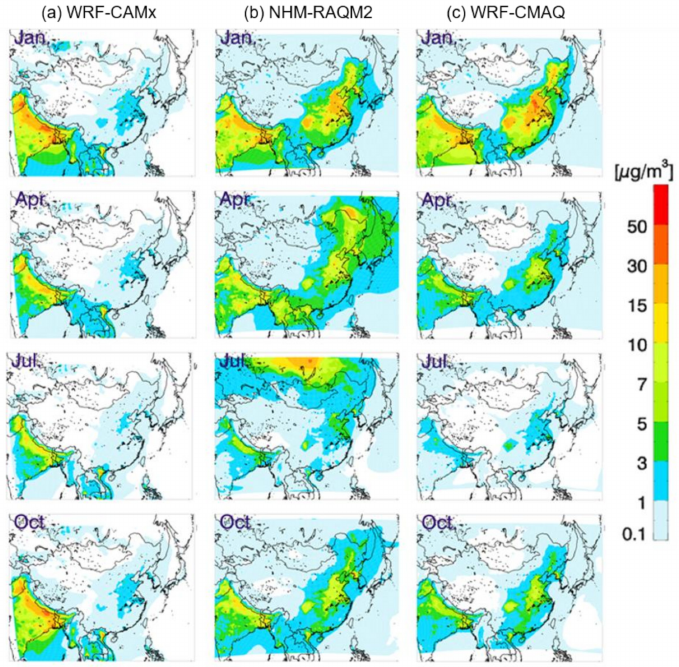
Figure 5. As in Figure 2, but for organic carbon (OC) concentrations ( µ g/m 3